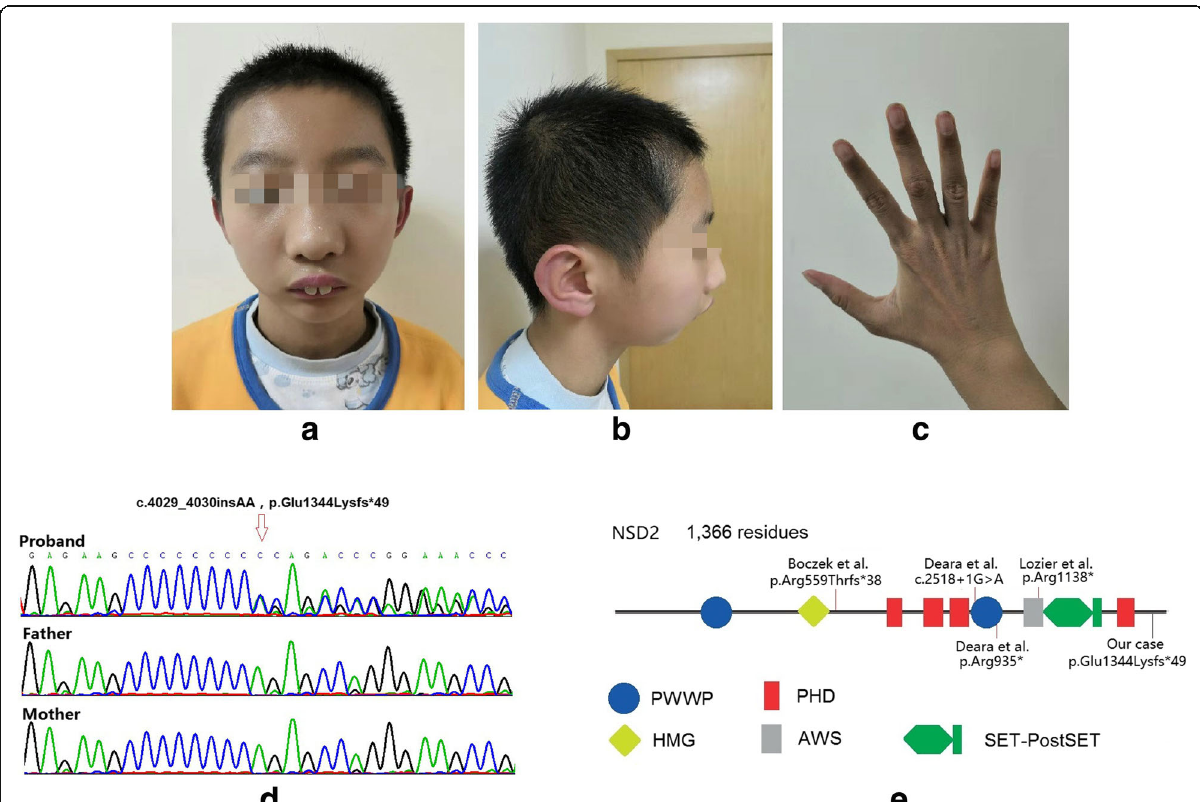
Fig. 1 a & b Facial features of the proband including wide-spaced eyes, prominent nasal bridge continuing to forehead, abnormal teething and micrognathia. c Mild clinodactyly was noticed on both hands. d Sanger confirmation of the truncating variants detected in the pedigree. e Sketch map of NSD2 gene domains and variants location of previously reported cases. (PWWP: Pro-Trp-Trp-Pro conserved motif; HMG: High mobility group box; PHD: Plant Homeodomain finger; AWS: associated with SET domain; SET: suppressor of variegation, enhancer of zeste, and Trithorax